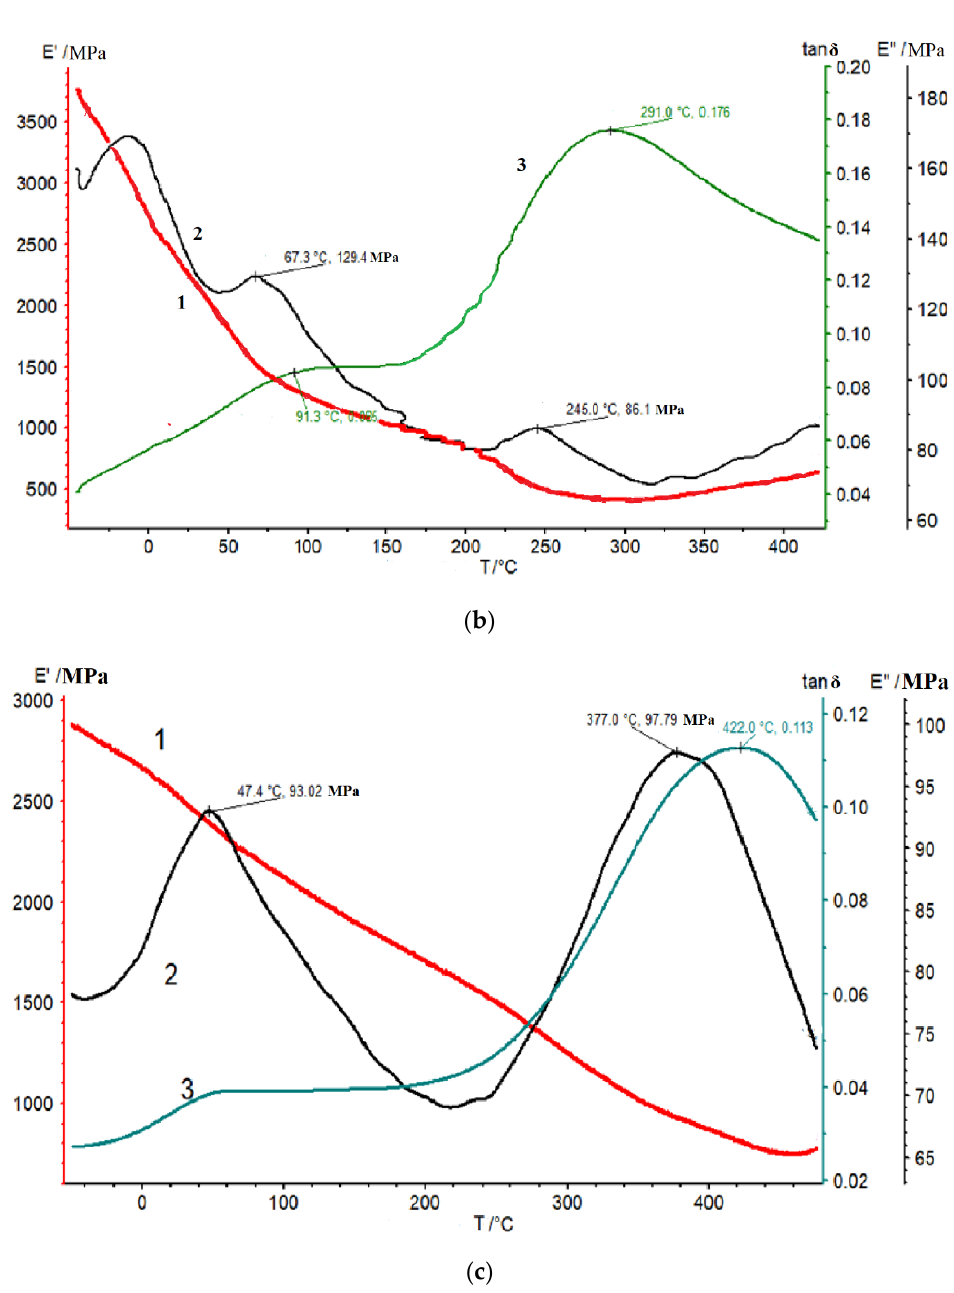
Figure 3. DMA curves of copoly(urethane-imide) samples thermalized for 30 min at temperatures: 170 °C ( a ); 300 °C ( b ); 350 °C ( c ). Temperature dependencies E’ (red curve), E’’ (black curve) and tan δ (blue curve).